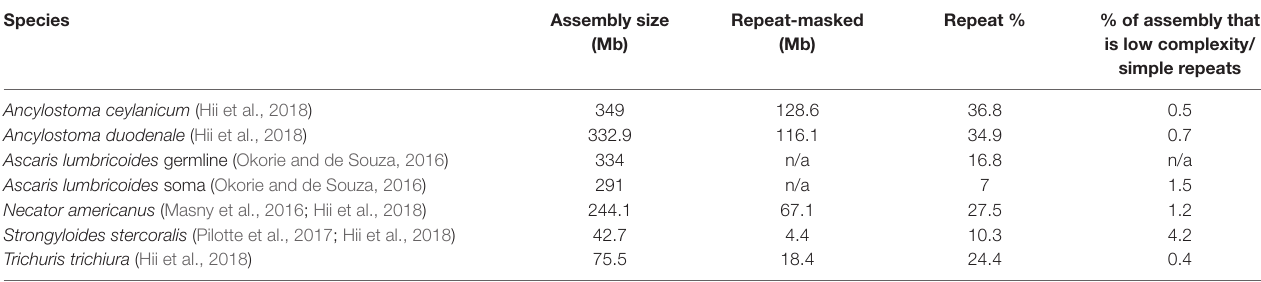
TABLE 1 | Genome size of representative helminth species and the amount/percent of genome masked as repetitive. Low complexity repeats and simple (for example di- or tri-nucleotide repeats) are not targets for molecular assays.